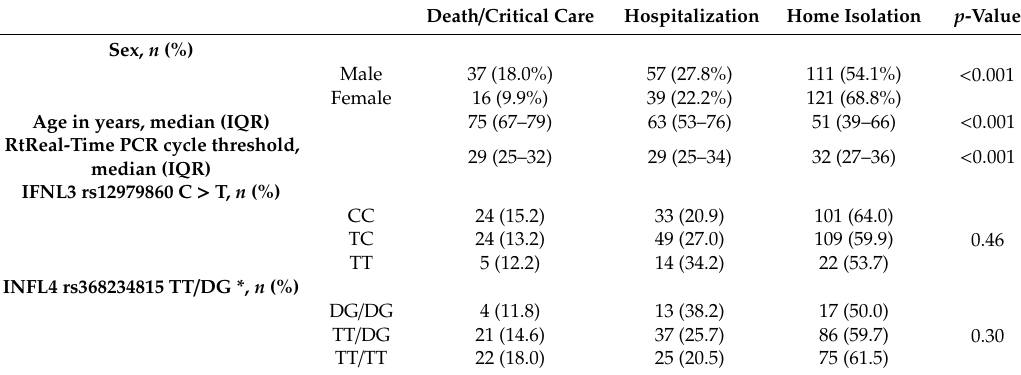
Table 3. Univariate analyses on predictors of clinical outcomes.